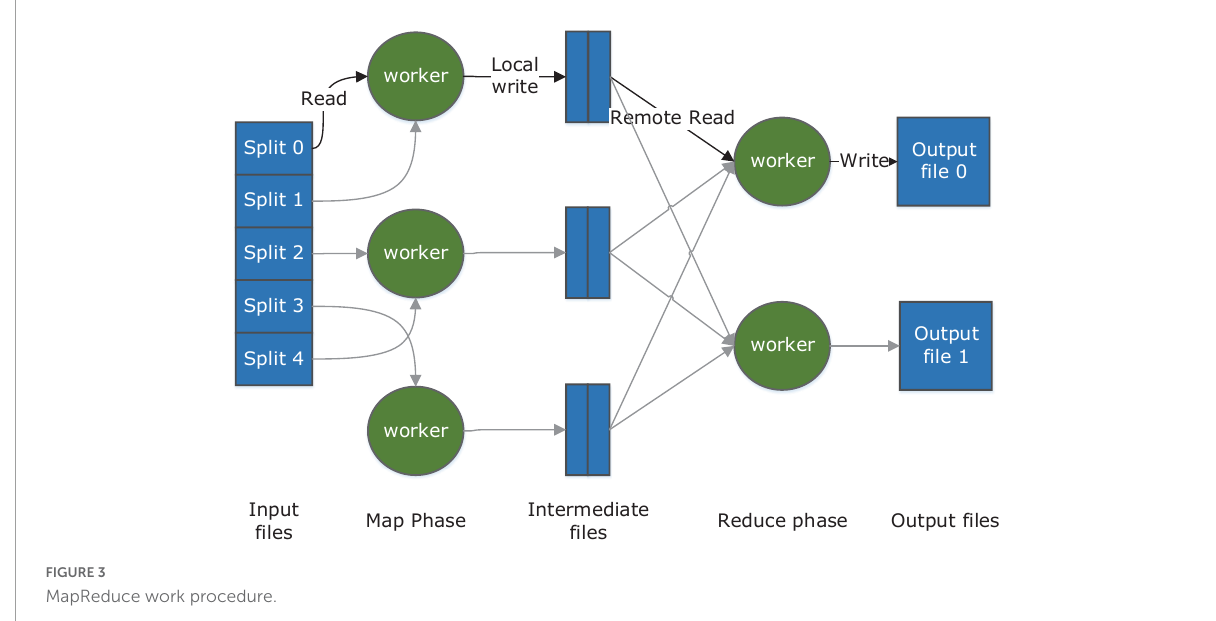
FIGURE3 MapReduce work